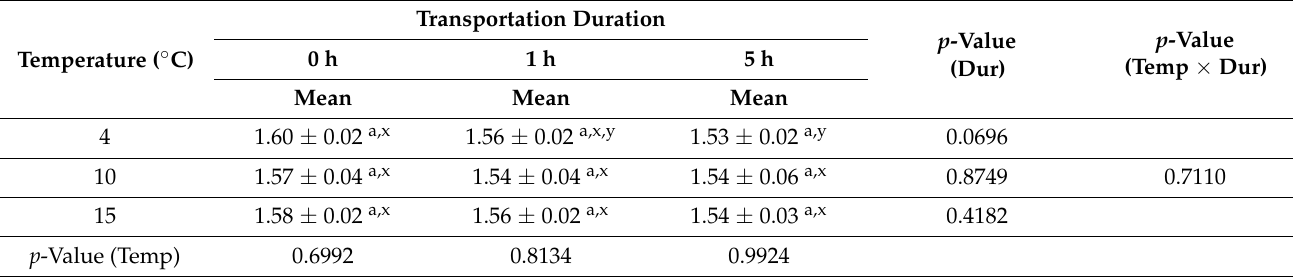
Table 5. Effects of transportation temperatures (4 ◦ C, 10 ◦ C, and 15 ◦ C) for two different transportation durations (1 and 5 h) on the shear force values (kg) of pectoralis major muscles in broiler